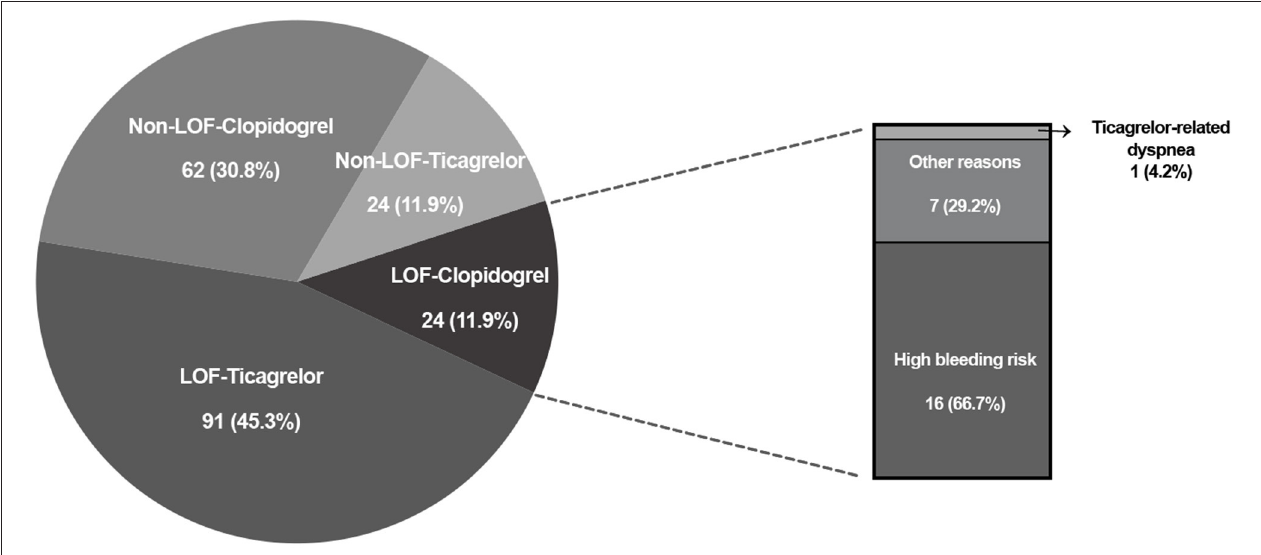
FIGURE 2 | CYP2C19 LOF alleles distribution and P2Y 12 receptor inhibitors selection in genotype-guided treatment group. LOF, loss-of-function.